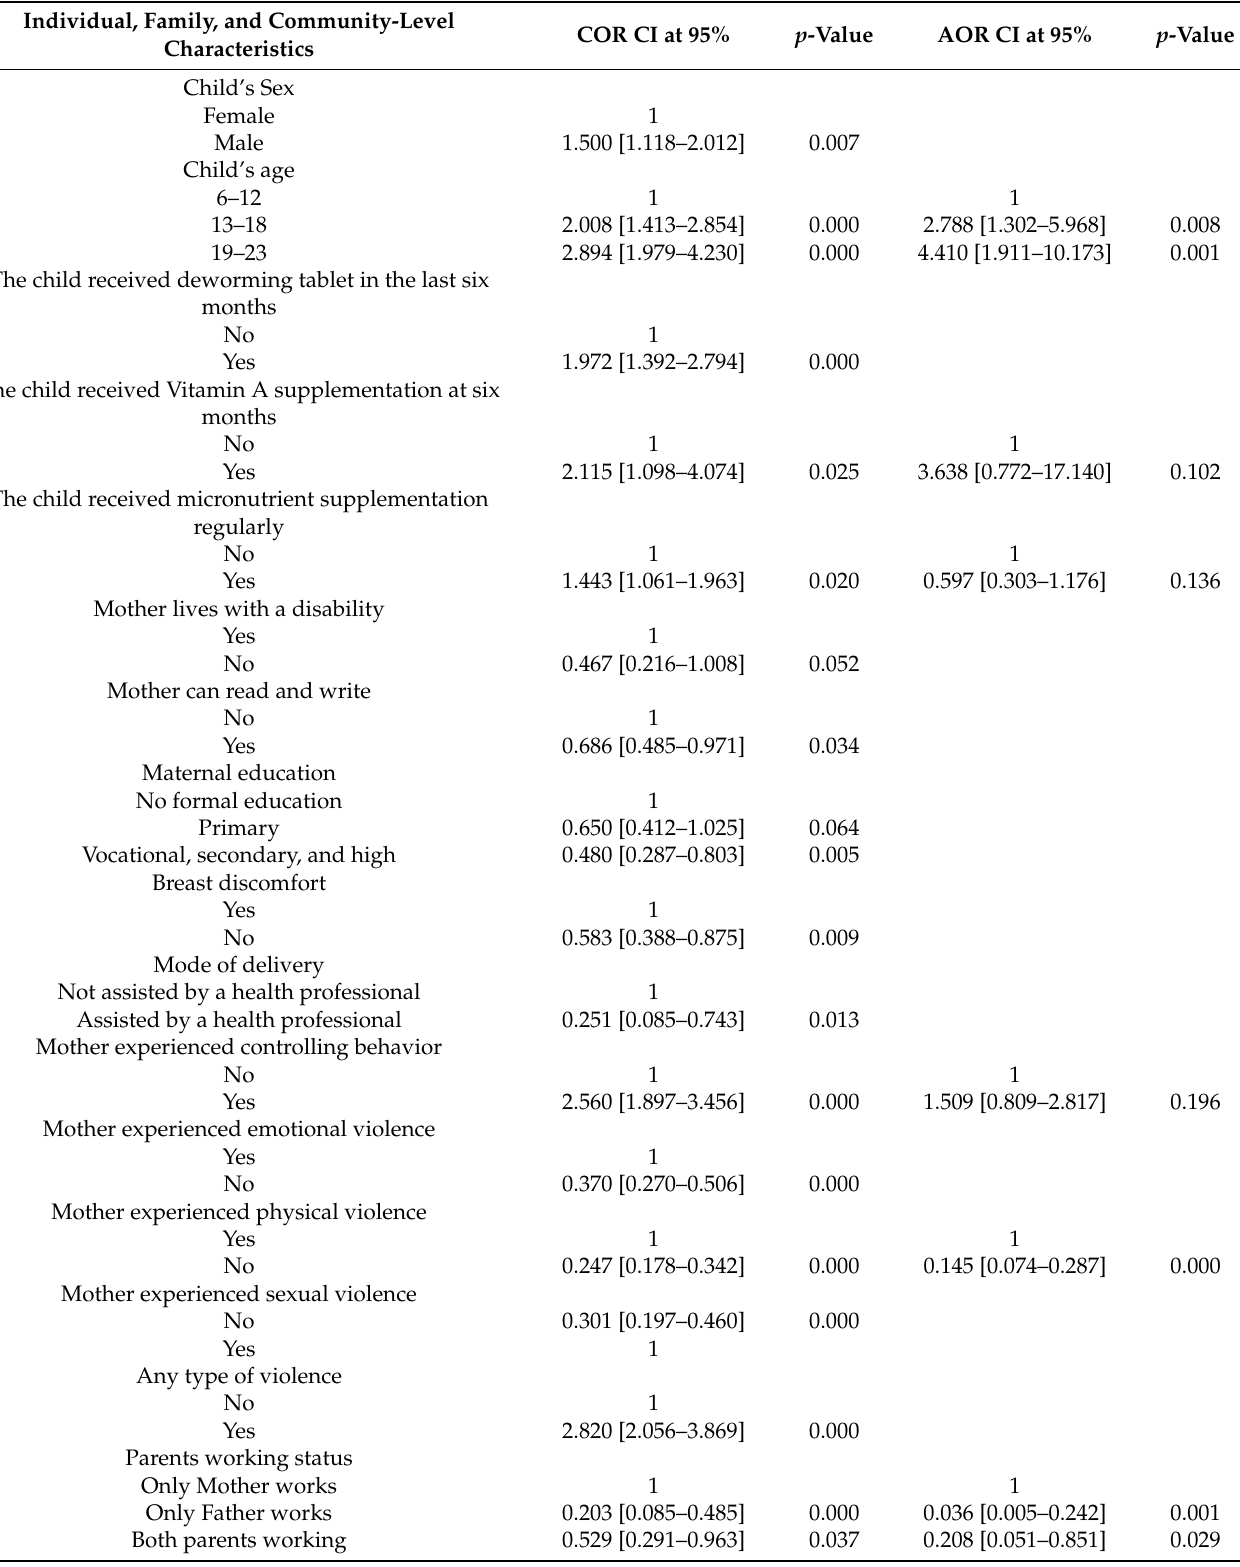
Table 2. Multivariate analysis: factors associated with childhood